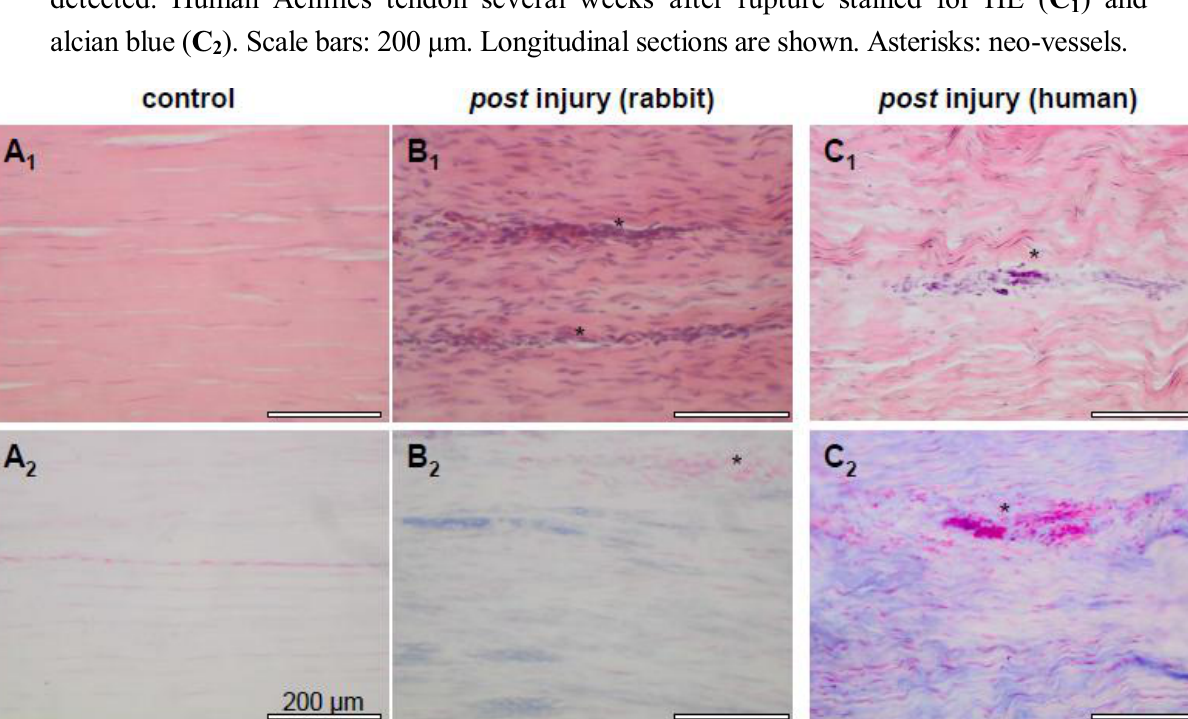
). The 2 ) could be 2 ) and 1